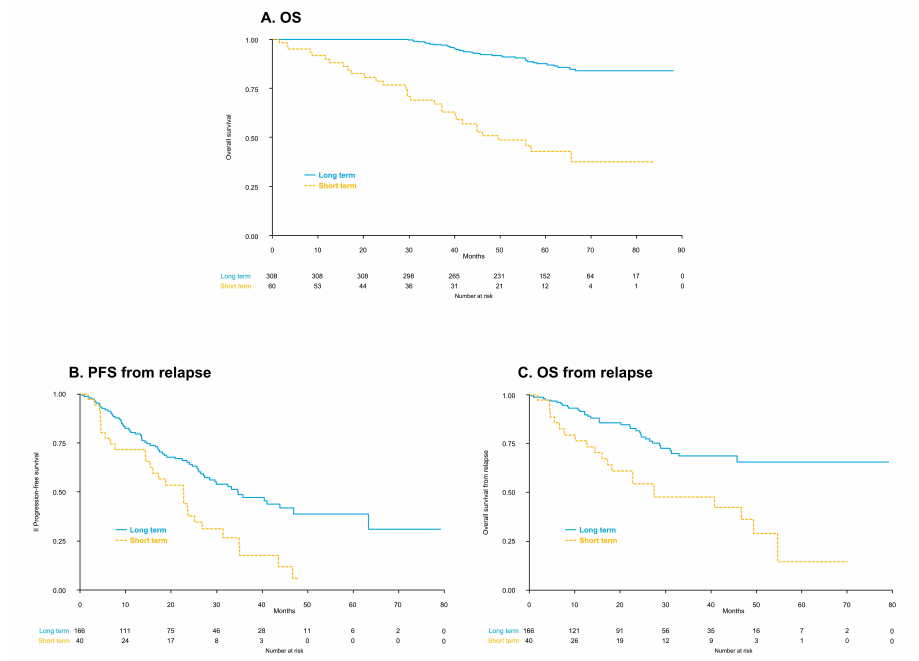
Figure 3. Outcome in patients continuing maintenance for more than 2 years (long-term